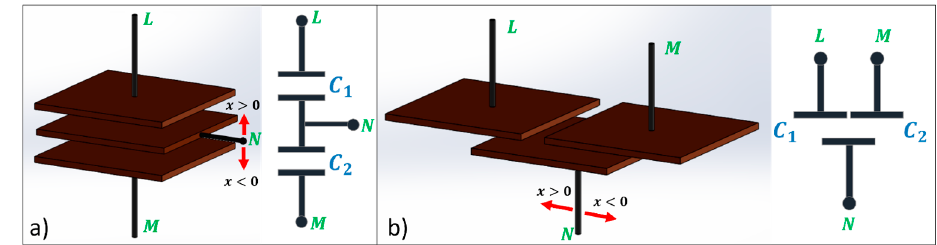
Figure 1. Differential capacitive sensor structure: ( a ) when the measurand influences the distance between plates; ( b ) when the measurand influences the overlapping area of plates.